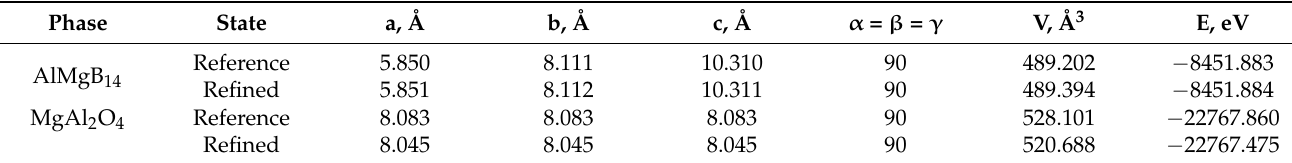
Table 2. Structural parameters of